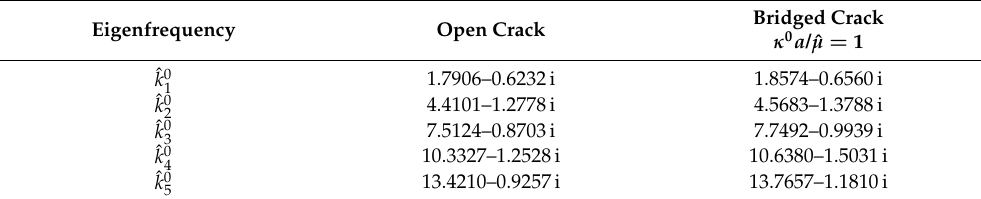
Table 6. Eigenfrequencies ˆ k 0 n for open and bridged cracks between aluminium and polycarbonate.